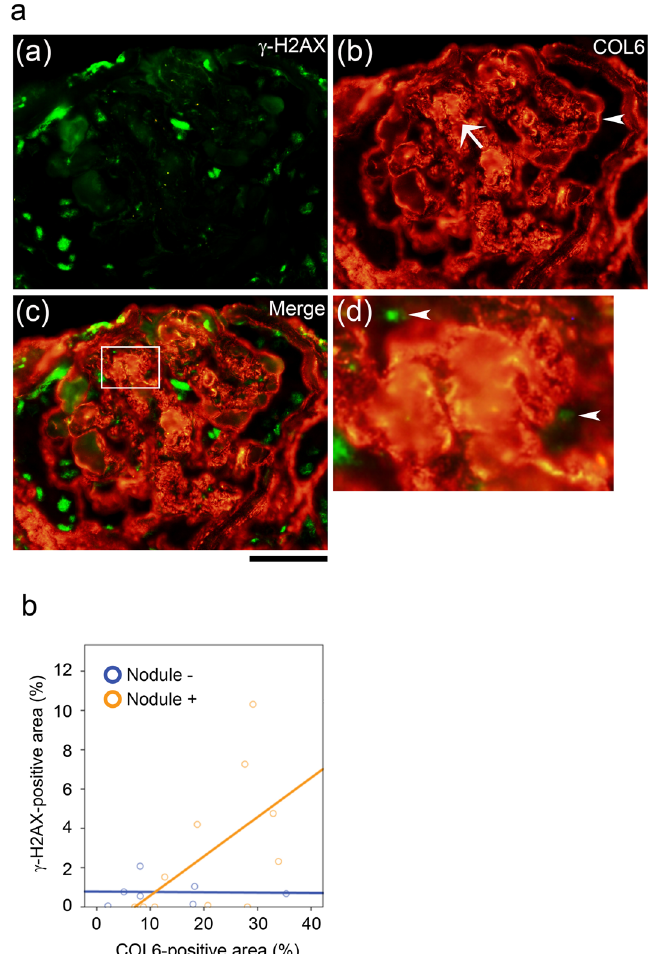
Figure 1. Characteristics of nodular glomerulosclerosis. [ a ] Double staining for γ-H2AX ( a ), COL6 ( b ), and both ( c ). Scale bar: 50 µm. ( d ) High power image of the white square of ( c ). Representative images of typical diabetic nodular glomerulosclerosis are shown. The arrow shows the nodular lesion, and the arrowhead shows a capillary loop in ( b ). The arrowheads in ( d ) show the γ-H2AX-positive nuclei of glomerular capillary cells. [ b ] The percentage of γ-H2AX-positive area and COL6-positive area was correlated in patients with nodular glomerulosclerosis (rS = 0.642, p =